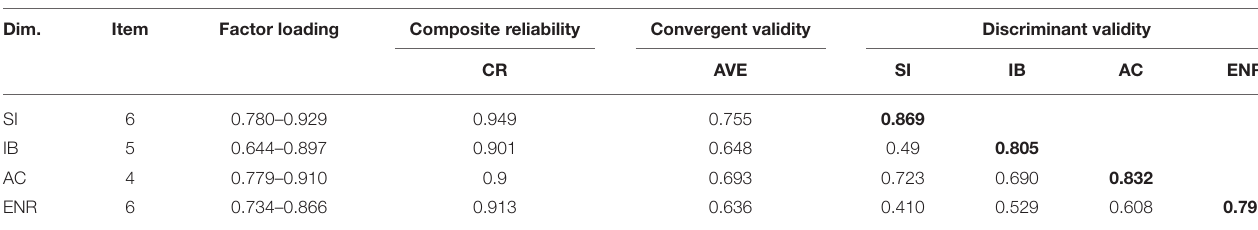
TABLE 3 | Reliability and validity analysis. Dim.